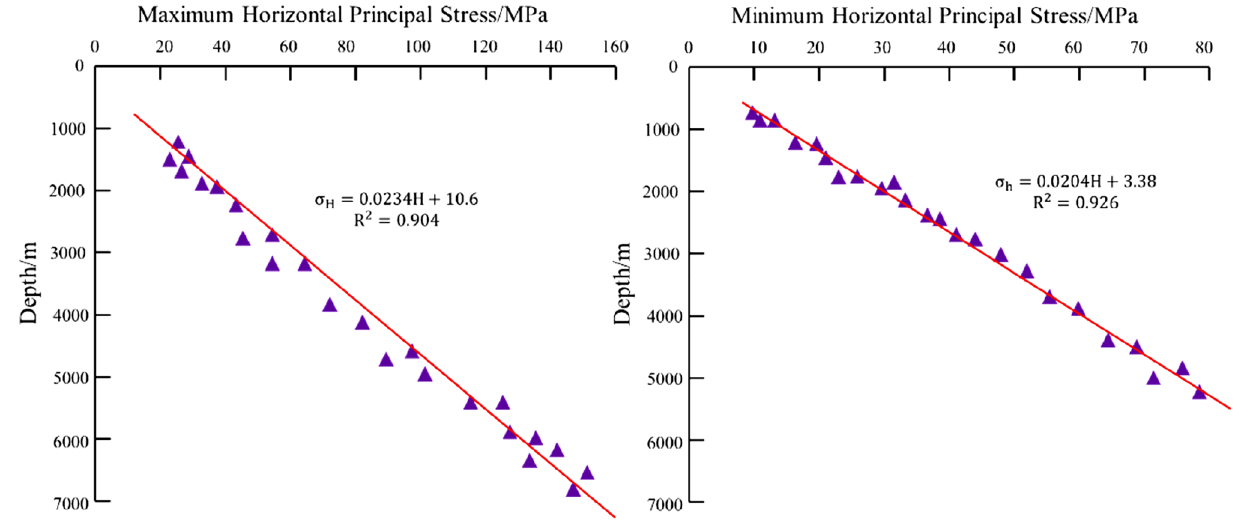
Fig. 9 Variation of horizontal principal in situ stress with buried depth in Northeastern